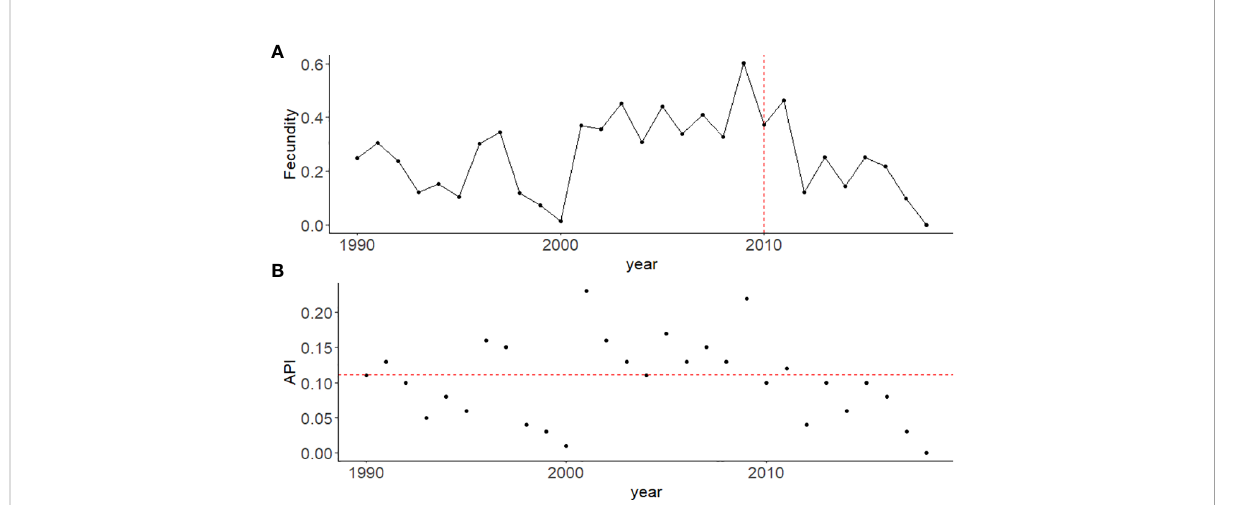
FIGURE 5 Reproductive measures for population growth for female North Atlantic right whales from 1990 – 2018. (A) The yearly fecundity rate, measured as the proportion of calves detected to the number of reproductively available females in the population per year. The vertical dotted line (red) indicates 2010, after which abundance of female breeders started to decline. (B) Annual productivity index (API) calculated as the total number of calves detected in a given year/average abundance estimate per year (N t ). The horizontal dotted line (red) indicates the average API of 0.11 for this